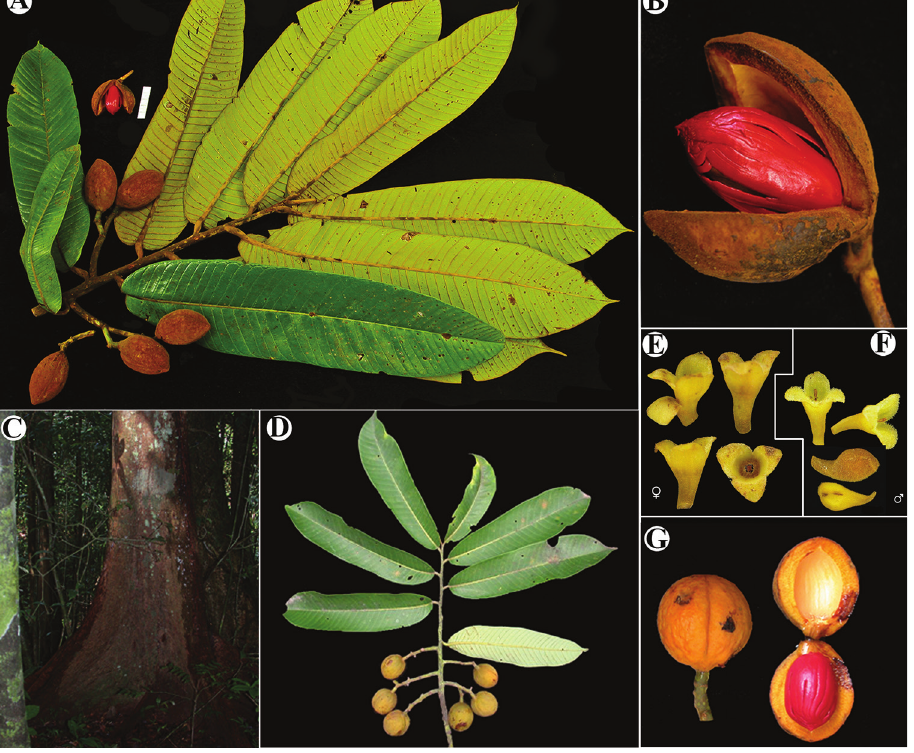
Figure 20. A. Virola megacarpa A branch with fruits, both leaf blade surfaces shown B fruit. Virola no- bilis from Barro Colorado C lower trunk and buttress D branch with fruits, leaf blades on both surfaces E pistillate flowers F staminate flower and bud G fruits. Photos by Carmen Galdames ( A, B ), Rolando Pérez ( C, D, G ), Steven Paton ( E, F ); all photos from